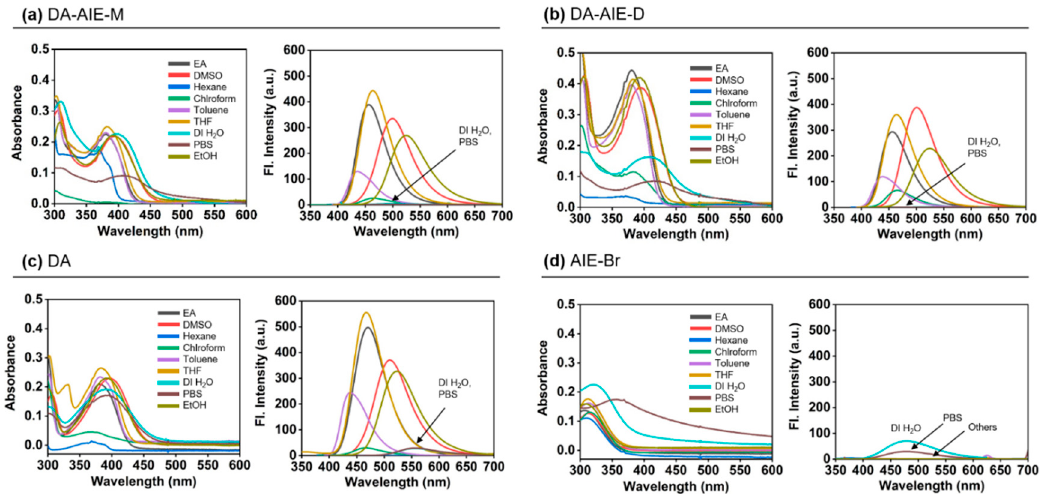
Figure 3. Absorption (left) and emission (right) spectra of ( a ) DA-AIE-M (10 μ M), ( b ) DA-AIE-D (10 μ M), ( c ) DA (10 μ M), and ( d ) AIE-Br (10 μ M) in various solvents at 25 °C. Solvents: EtOAc (ethyl acetate), DMSO (dimethyl sulfoxide), hexane ( n -hexane); chloroform, toluene, THF (tetrahydrofuran), DI H 2 O (deionized water), PBS (phosphate-buffered saline, pH 7.4), and EtOH (ethanol). The emission spectra were obtained in each solvent under excitation at the maximum absorption wavelength.